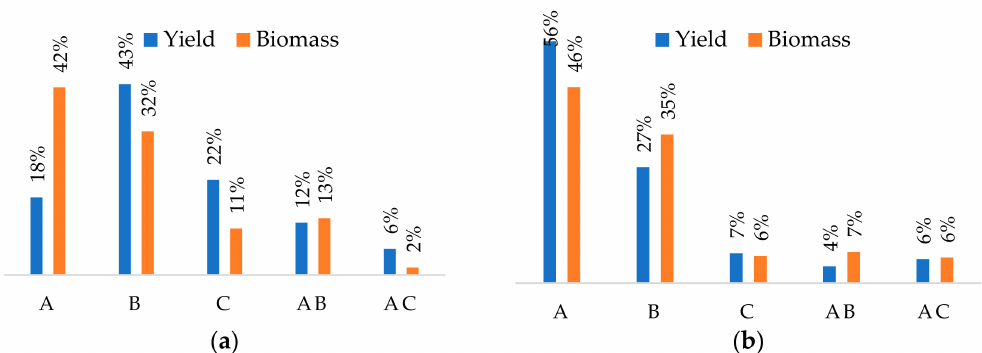
Figure 3. Contribution of the factors examined in the study (location-A, Fall N fertilizer application-B, Spring N fertilizer application-C) on yield and biomass of Ingenio ( a ) and NS40S ( b ) varieties in